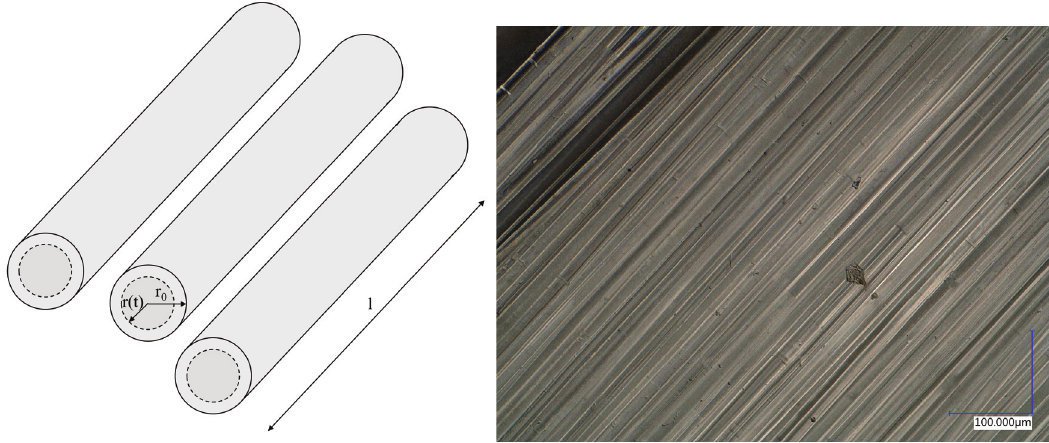
Figure 1: Left: Schematic representation of a fiber bundle and geometrical dimensions. Right: micrograph of a fiber